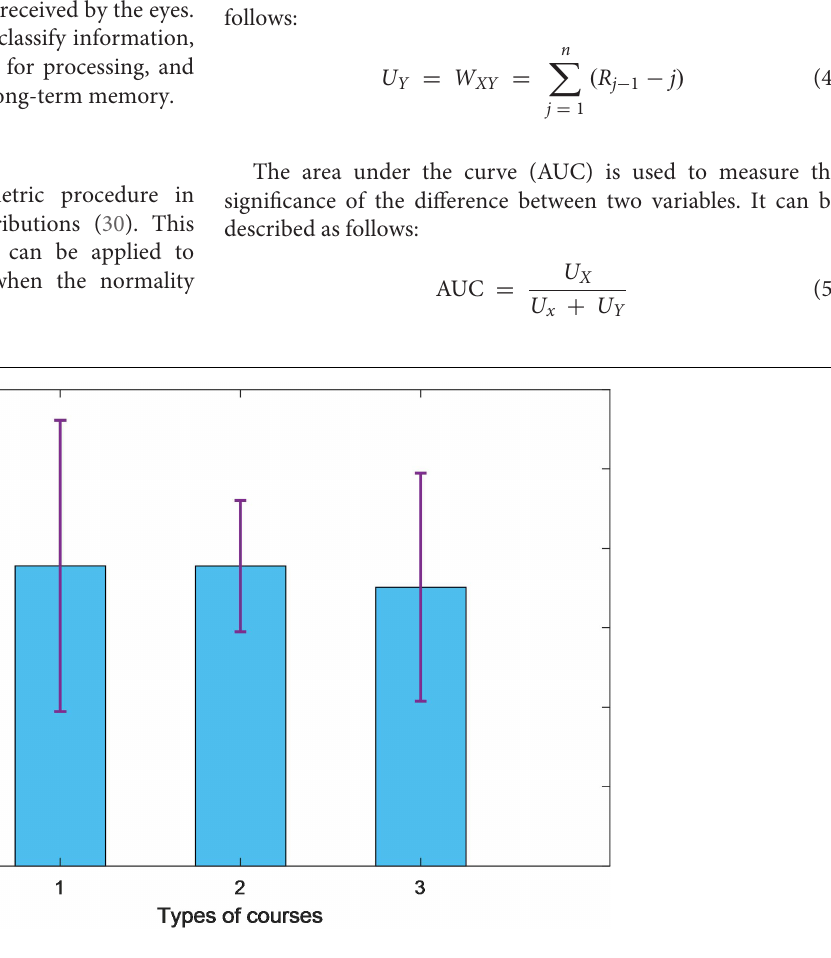
FIGURE 10 | Comparison of attention